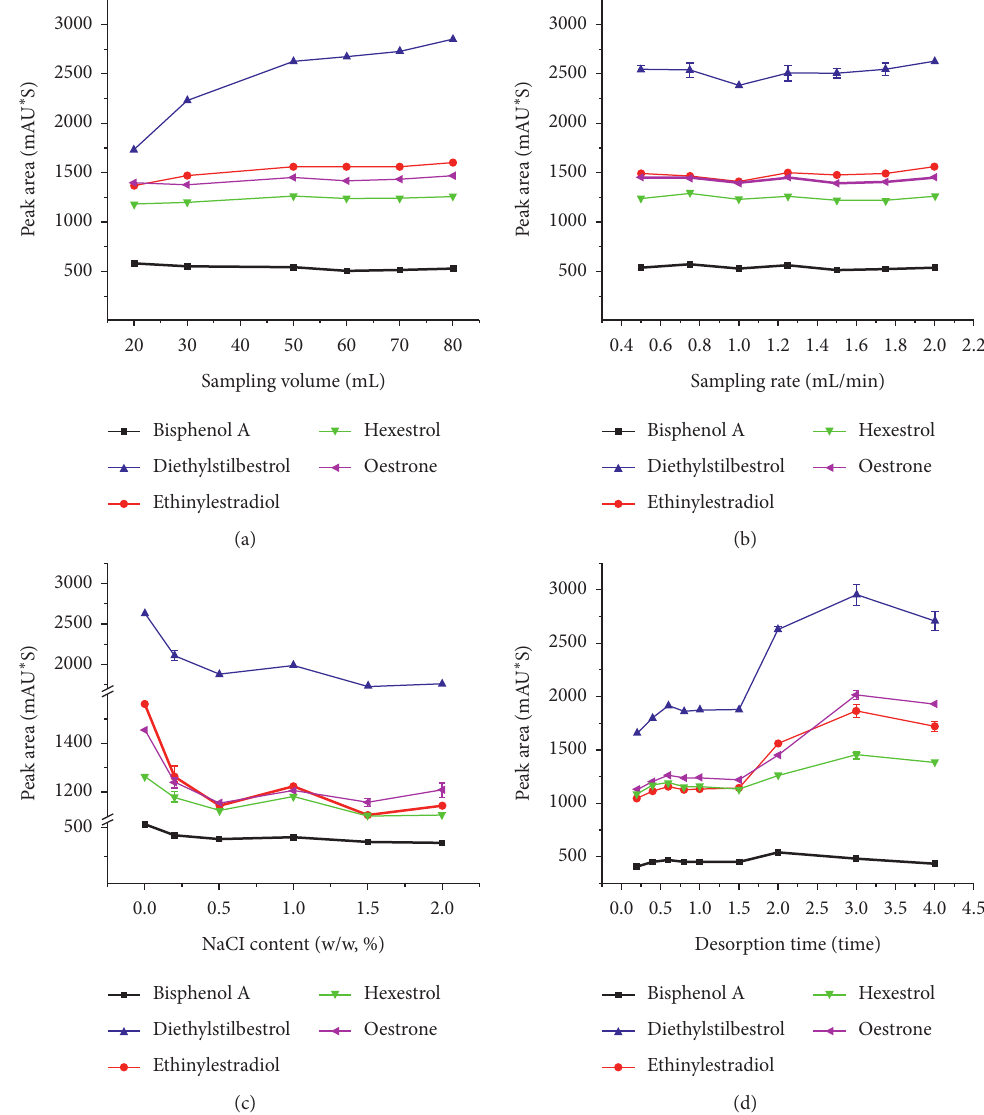
Figure 7: The optimization of extraction conditions including (a) sampling volume, (b) sampling rate, (c) NaCl content, and (d) desorption time. Condition: concentration of estrogens, 10 μ g/L. Other conditions are the same as in Figure 6.